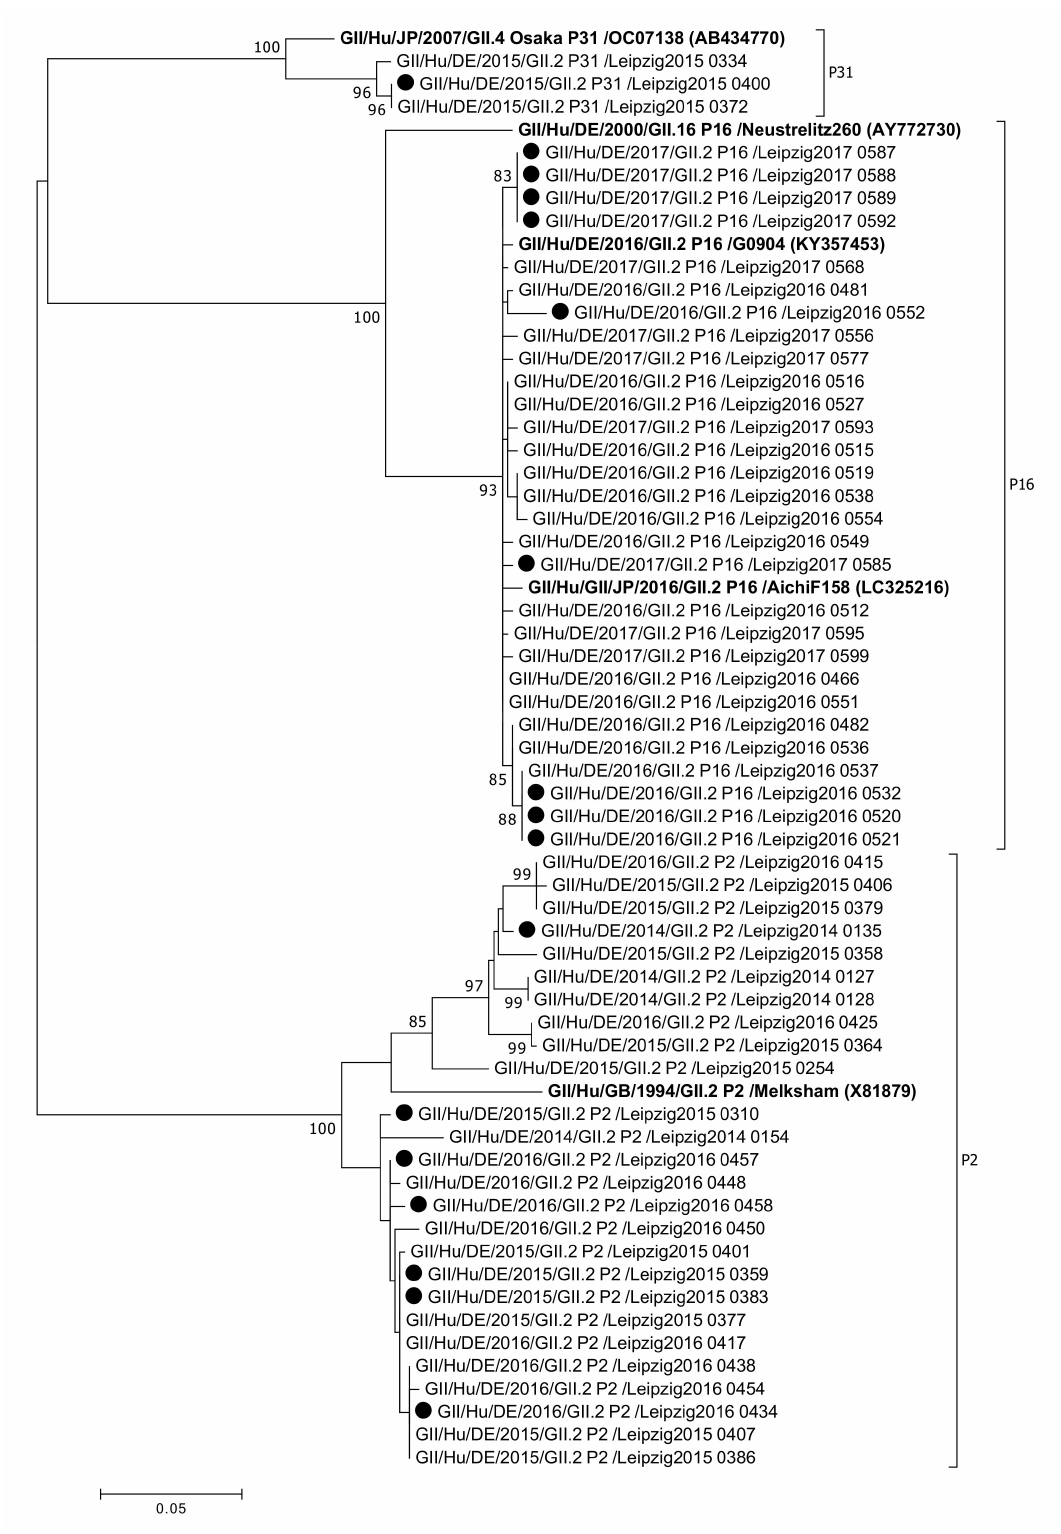
Figure 6. Phylogenetic analysis of norovirus GII.2 polymerase genotypes based on Maximum Likelihood estimations of partial ORF1 nucleic acid sequences. Exclusively, bootstrap values (1000 replicates) above 80% are shown. Black circles indicate sequences of nosocomial infections. Labels in bold indicate reference strains with GenBank accession numbers shown in